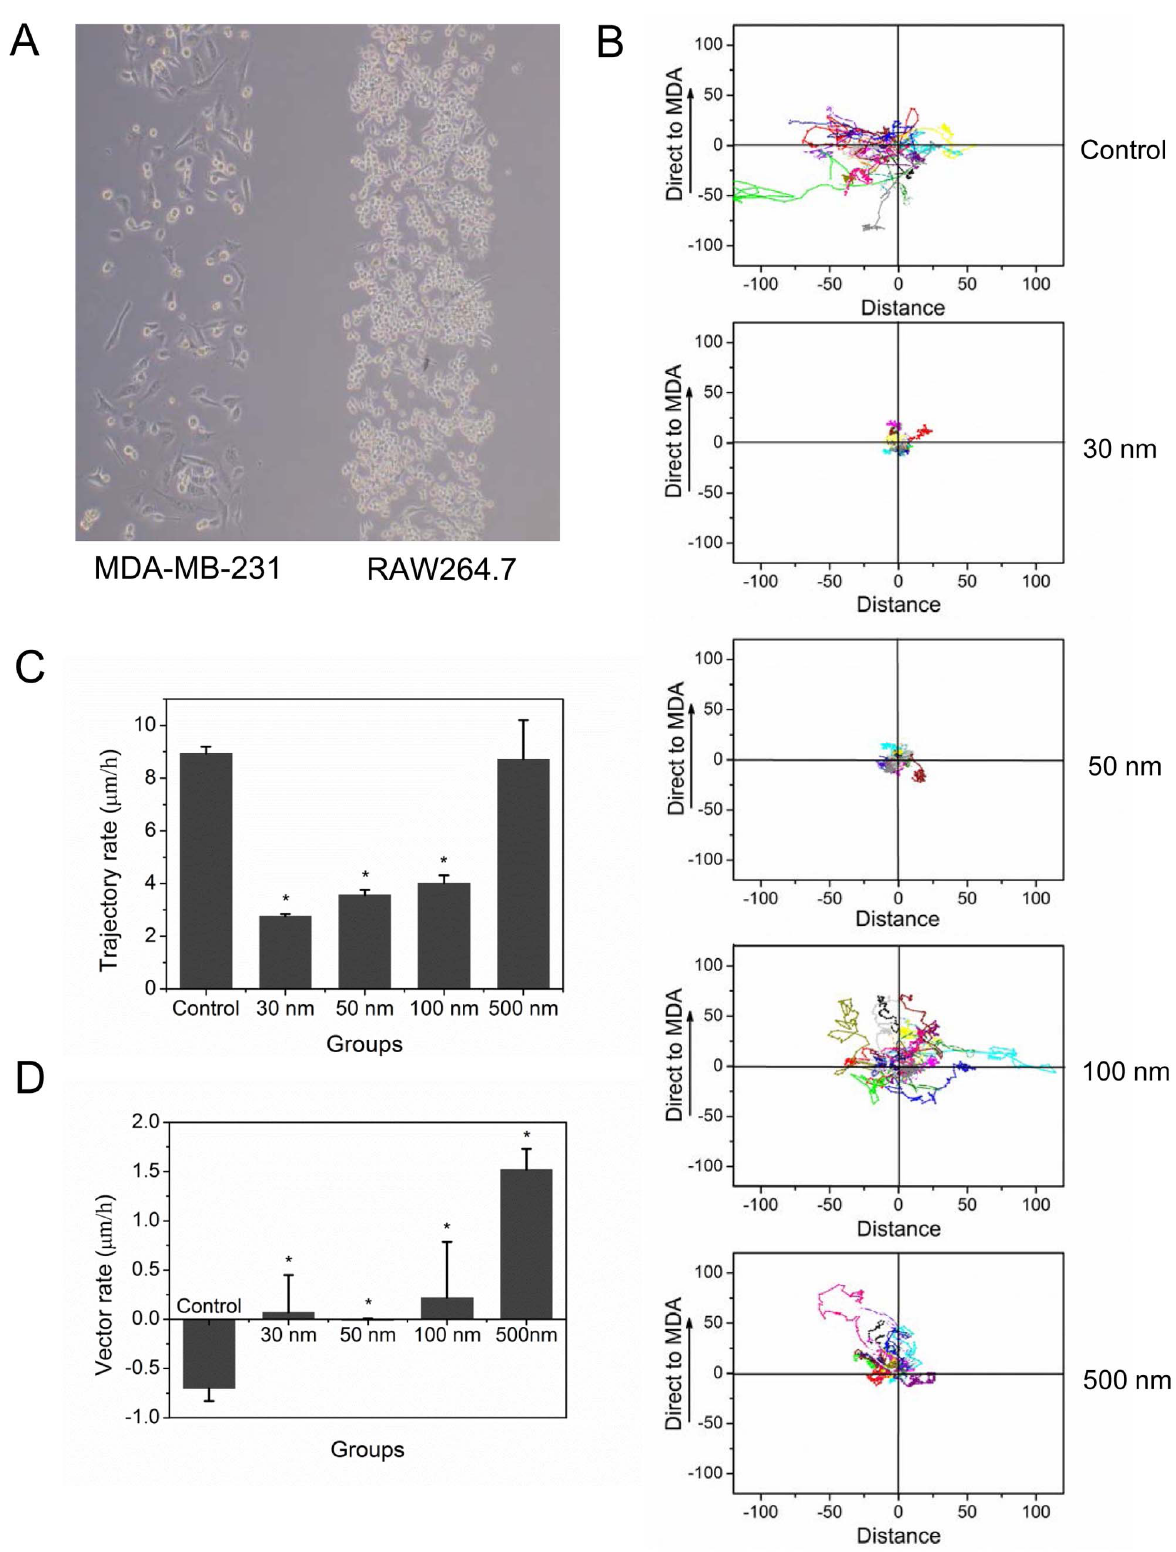
Figure 2. RAW 264.7 cells vector migration ability. A) Schematic of the optical microscope with microfluid technology for assessing macrophage vector migration ability. B) RAW264.7 cell mobility changed after NP uptake. Cell movement was followed by live confocal microscopy for 24 h. The origin of each cell is at the intersection of the x- and y-axis, 20 cells were assessed per experiment (performed in triplicate). Cell migration over a defined area was determined in fresh media in the control group vs. pre-treatment with 30-, 50-, 100-, and 500-nm NPs, respectively.